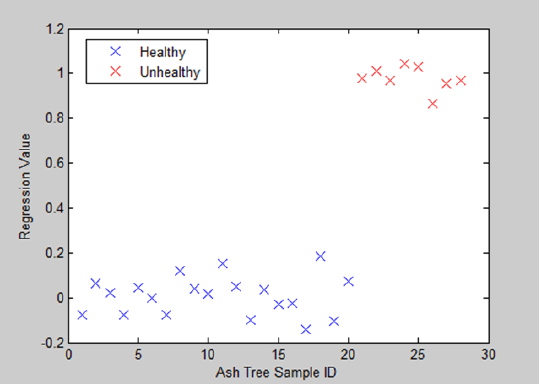
Figure 8. Regression values for the prediction of healthy and unhealthy ash trees in Site